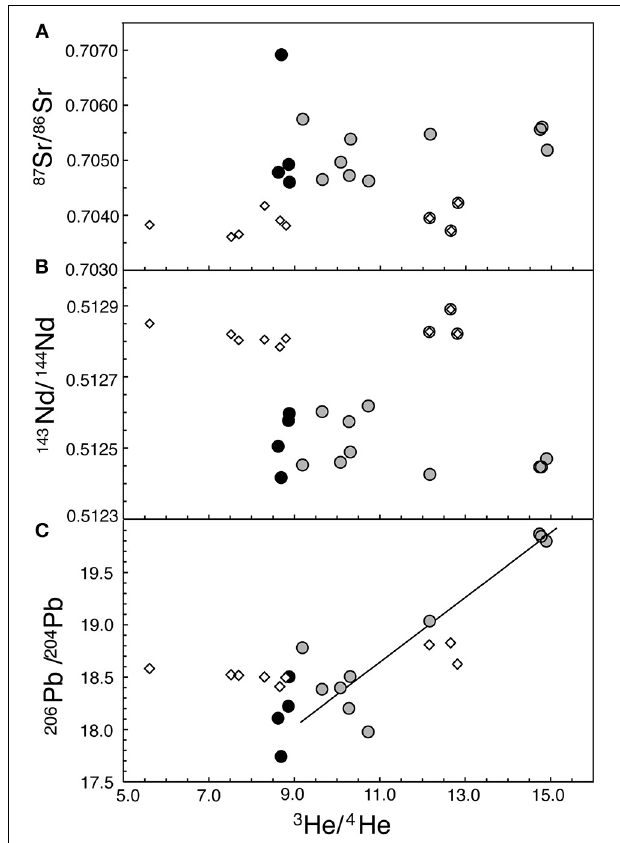
FIGURE 8 | 3 He/ 4 He vs. (A) 87 Sr/ 86 Sr and (B) 143 Nd/ 144 Nd and (C) 206 Pb/ 204 Pb for RVP and MER lavas. (Symbols as in Figures 2 , 7 ) 3 He/ 4 He does not correlate with 87 Sr/ 86 Sr and 143 Nd/ 144 Nd, most probably due to the long-term carbonatitic metasomatism of the lithospheric mantle. More explanation in the text. High 3 He/ 4 He RVP lavas show a strong positive correlation ( R 2 = 0 . 81) with 206 Pb/ 204 Pb. Significantly, high 3 He/ 4 He MER samples plot close to the line. Note that the MER sample with the highest 3 He/ 4 He (15.1 R A ) does not have corresponding Pb isotopic data (Rooney et al.,